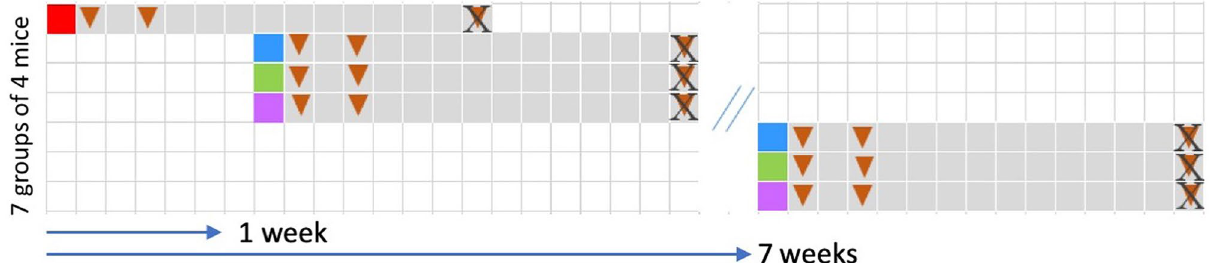
Figure 1. Experimental design. The first group of mice (n = 4) received a human stool suspension freshly prepared in NaCl (“red square”). The six following groups of mice (n = 4 per group) received the same stool specimen that has been prepared in NaCl (“blue square”) or MD (“green square”) or TR (“purple square”), and frozen for one or seven weeks. Fecal samples (“triangle”) were collected from each mouse at day 2, 4 and 15 after FMT for individual metagenomic profiling. End of experiment